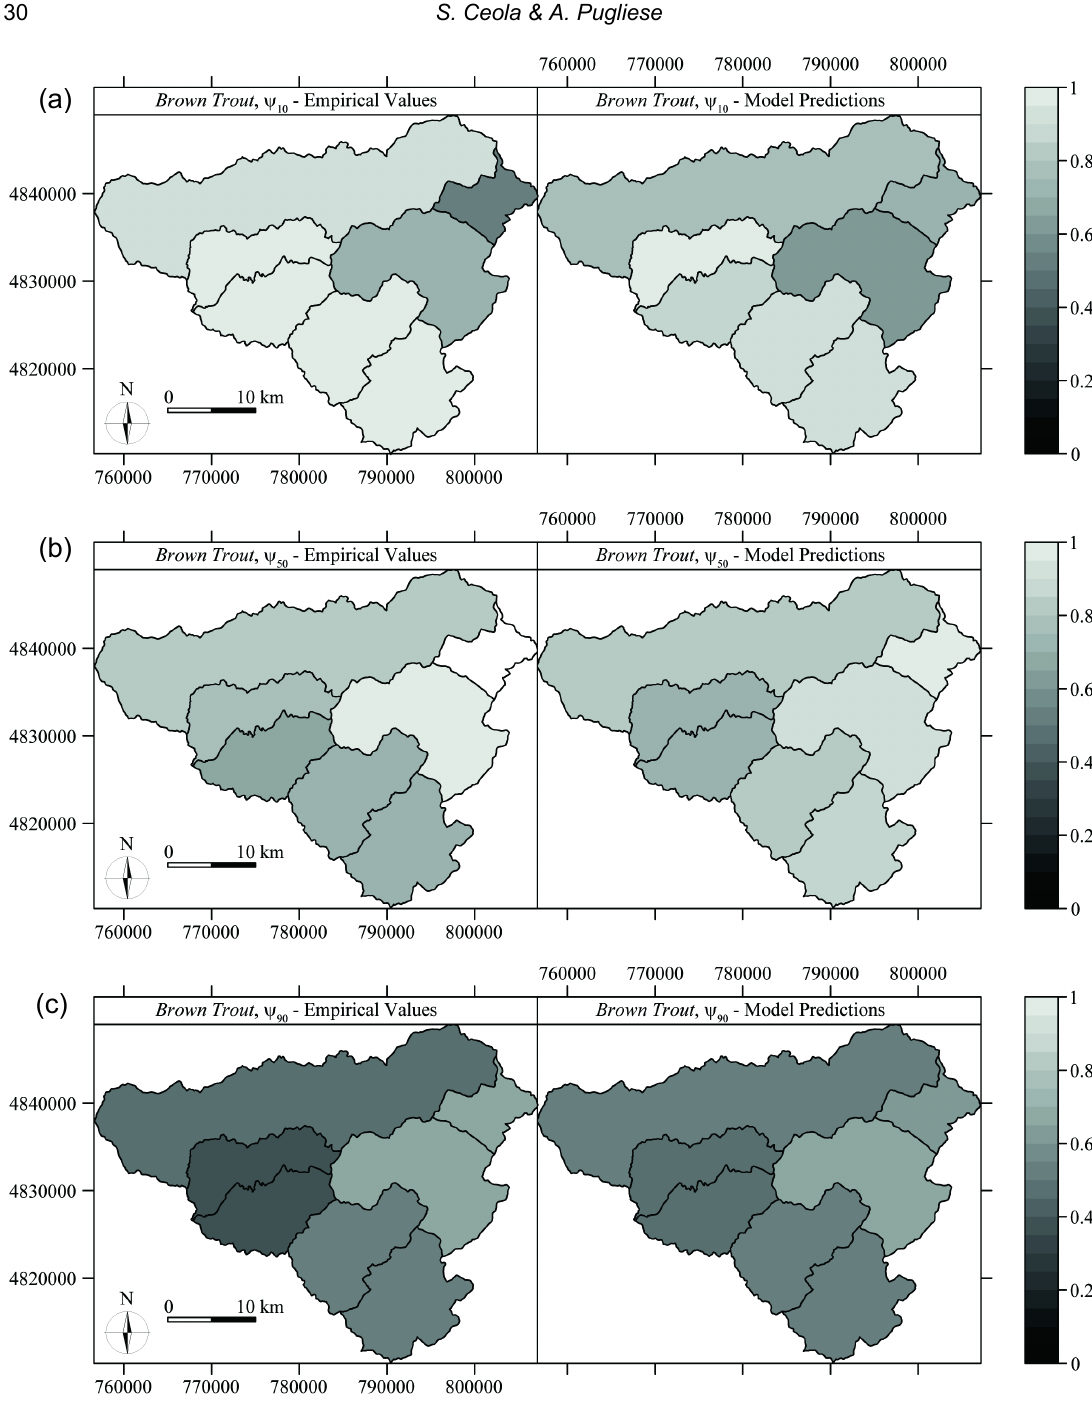
Fig. 4 Brown trout habitat suitability maps for the seven sub-basins in the Metauro River. Comparison of empirical values (i.e. derived from water depth values) against model predictions from cross- validation (equations (2) and (3)) for: (a) 0.1-quantile, (b) 0.5-quantile, (c)